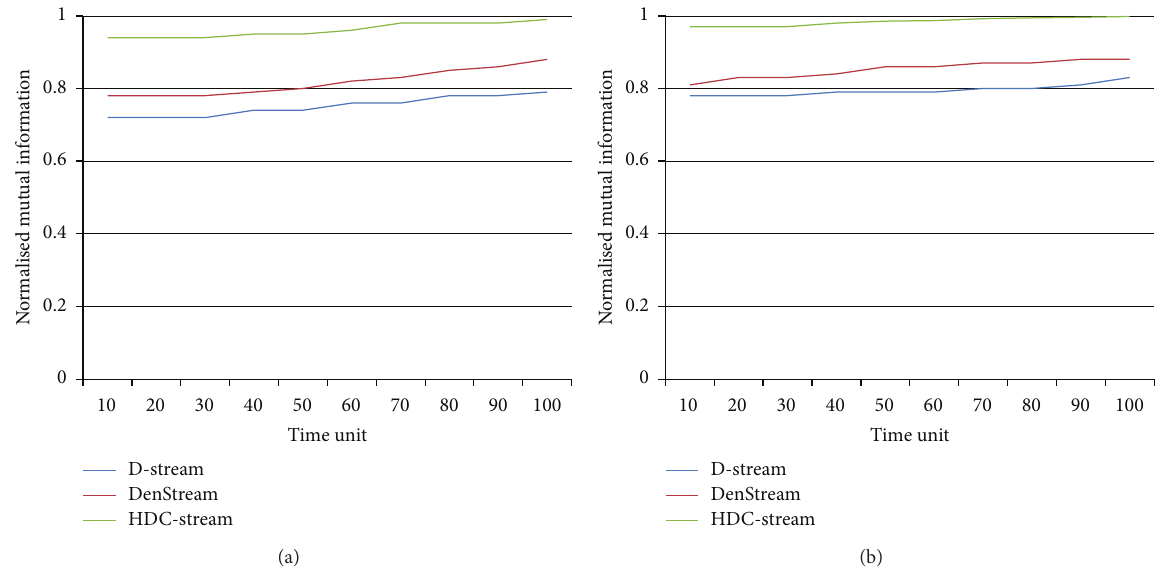
Figure 8: Normalised mutual information of HDC-Stream on Network Intrusion Detection dataset with (a) horizon = 1 and stream speed = 1000, (b) horizon = 5 and stream speed = 1000.